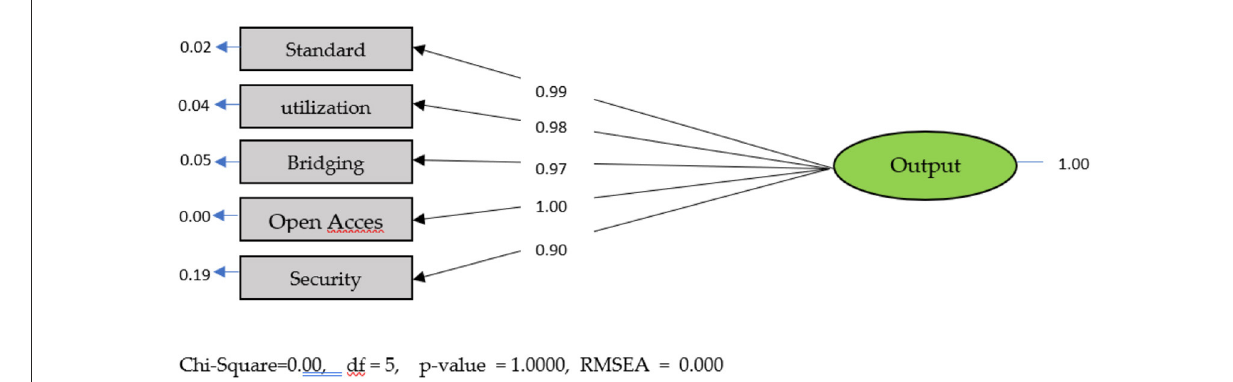
FIGURE4 Standard output model solution.